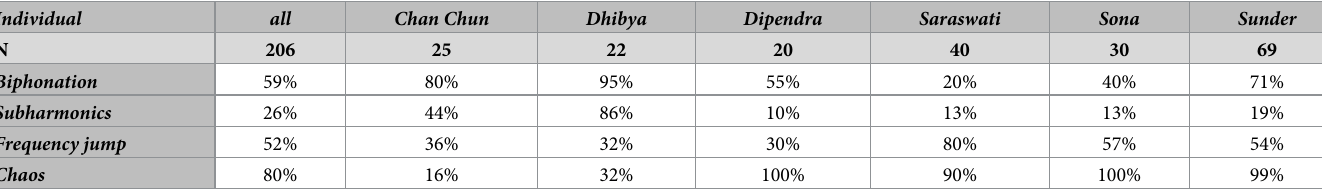
Table 6. Occurrence of NLP as a percentage of all trumpets per individual.